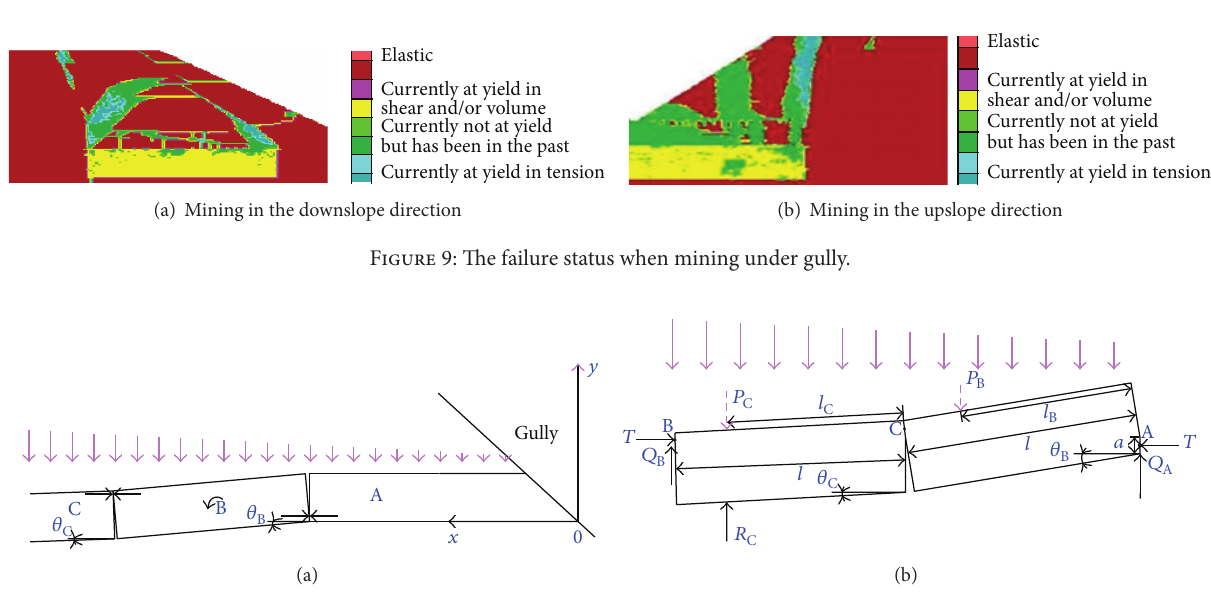
Figure10:Mechanicalmodelforroofbeamwhenminingindownslopedirection.(a)Theassumedmechanicalmodel;(b)mechanicalanalysis on blocks B and